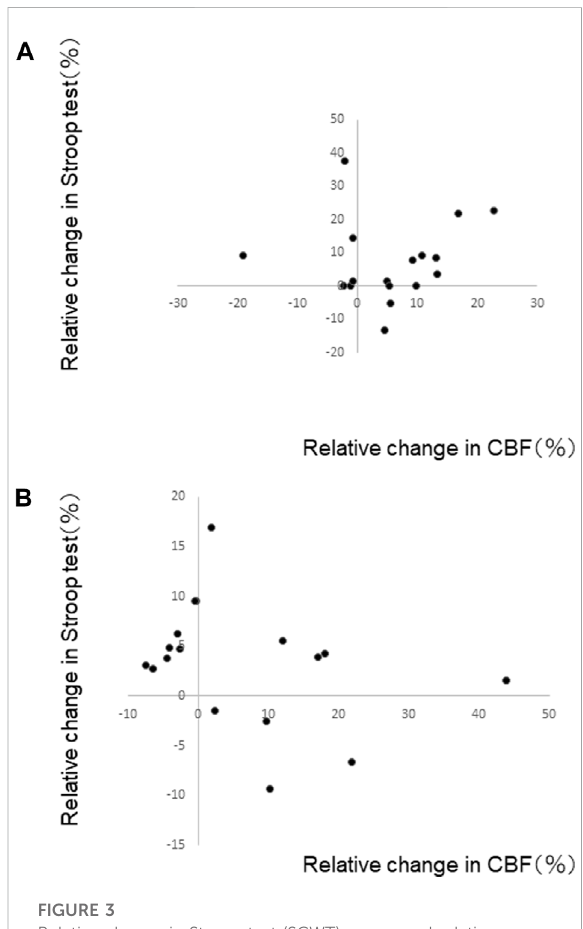
FIGURE 3 Relative change in Stroop test (SCWT) scores and relative change inmiddle cerebral arteryblood fl owvelocity(MCAv)for (A) playingatafasttempo(PL80)and (B) readingmusicatafasttempo (RE80). The MCAv for the last minute of performance and the SCWT immediately after the performance were used. No signi fi cant relationship was